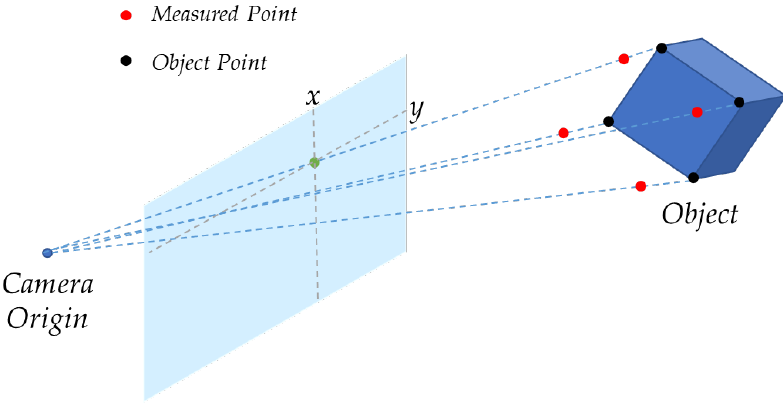
Figure 4. Three-dimensional ranging error presentation of the SL-based RGB-D sensor.